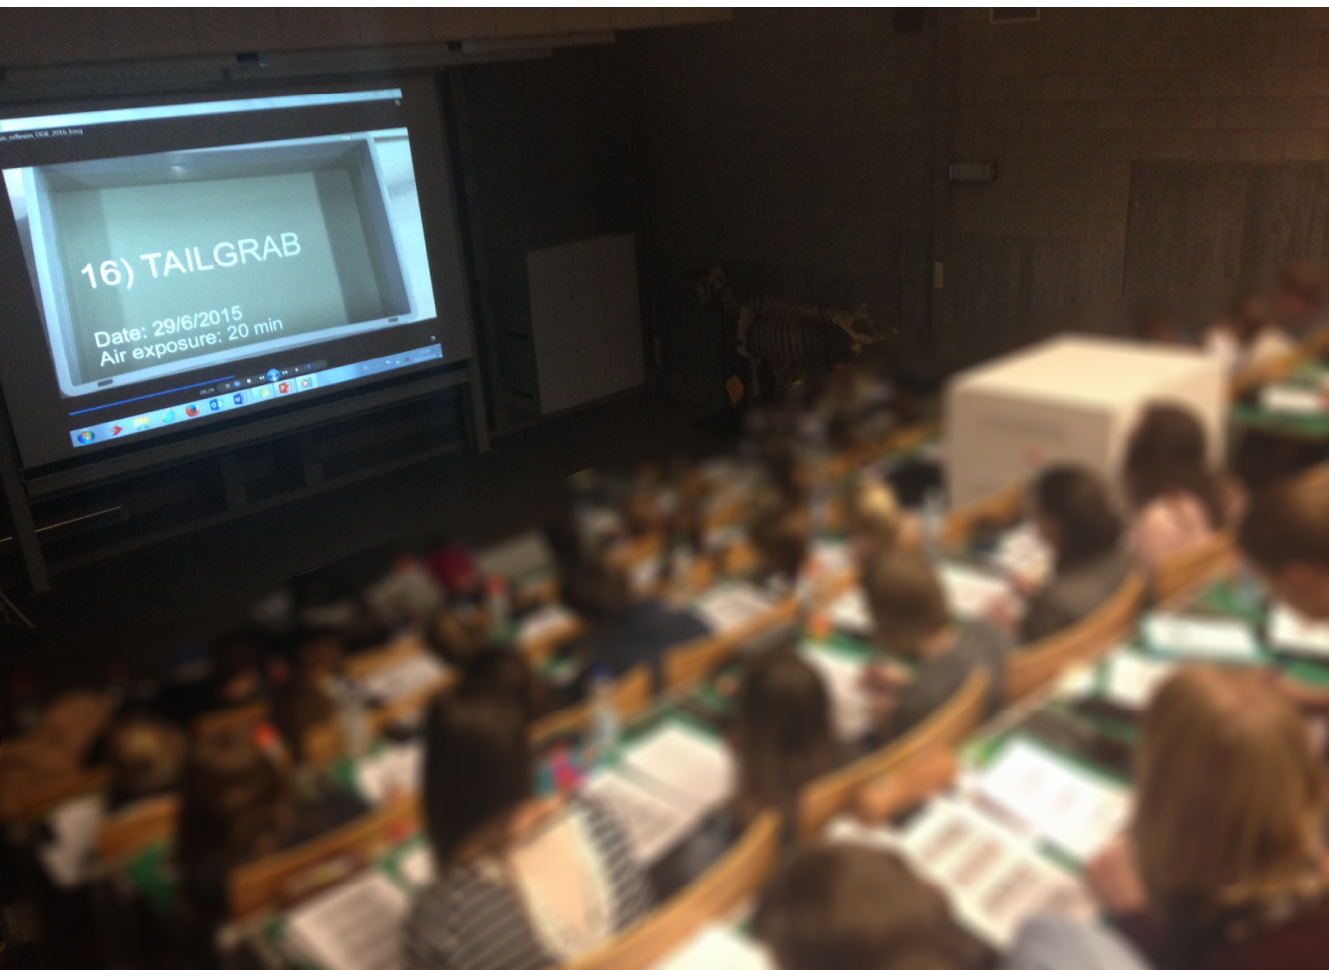
Fig 1. Lecture theatre view to illustrate video projection. Third-year veterinary medicine students from the University of Ghent independently scored a tail grab reflex response of a common sole ( Solea solea ) from a video clip projected onto a lecture theatre screen during a workshop session in April 2016. Note: The picture was blurred in parts to guarantee that any person in the audience cannot be identified to comply with the PLOS open-access (CC-BY) license.